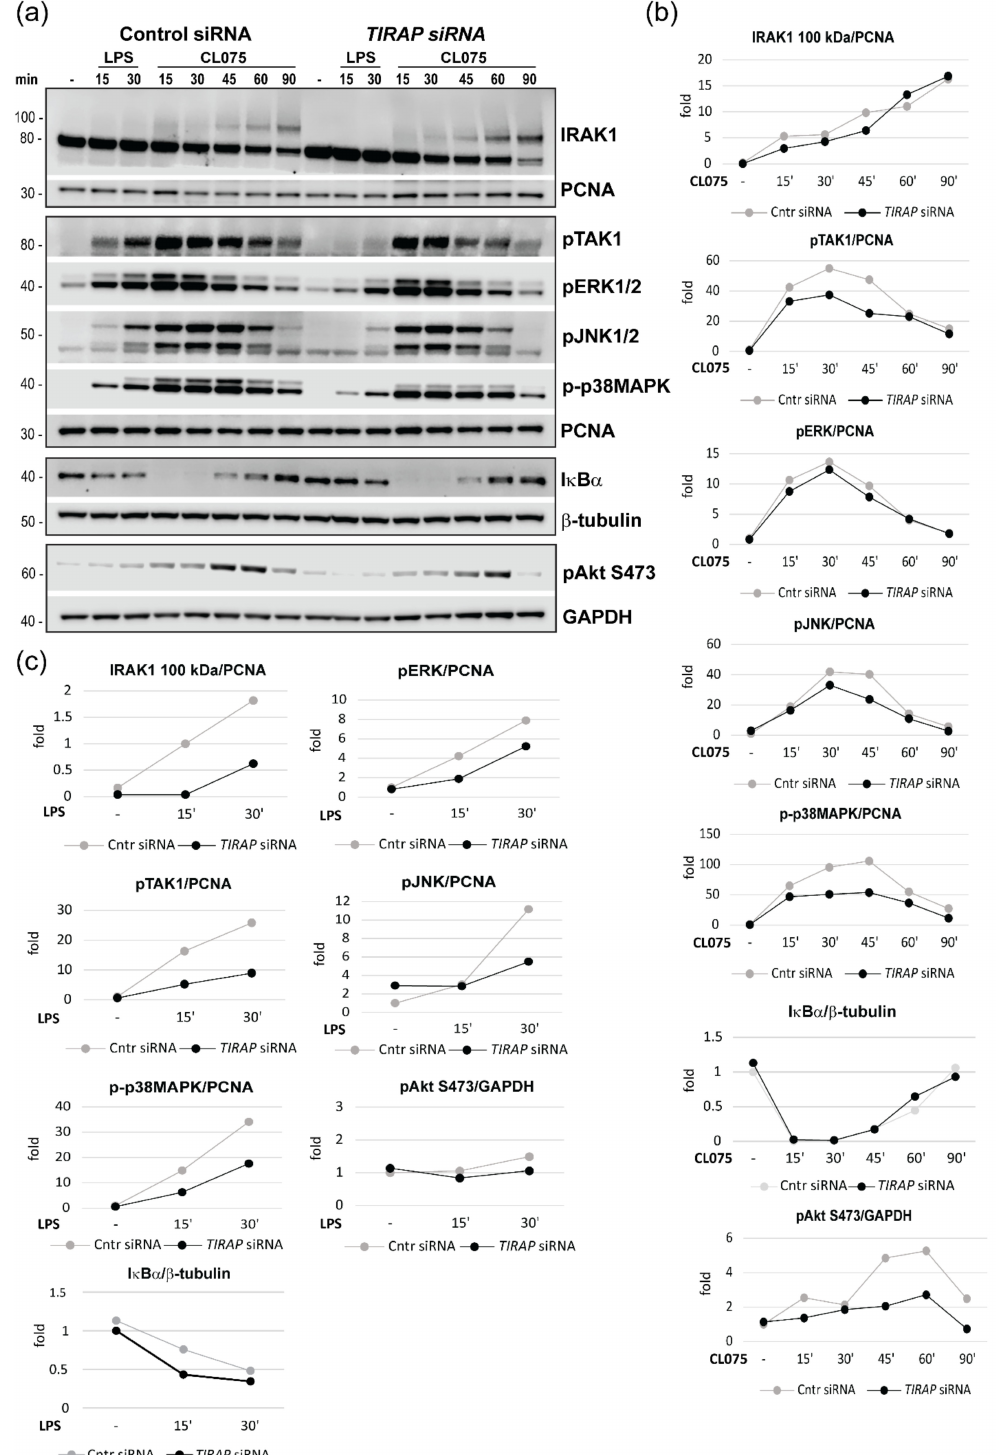
Figure 6. Silencing of TIRAP consistently inhibits TLR8-mediated phosphorylation of Akt S473. ( a ) Western blotting of lysates from MDMs treated with a control oligo or TIRAP -specific